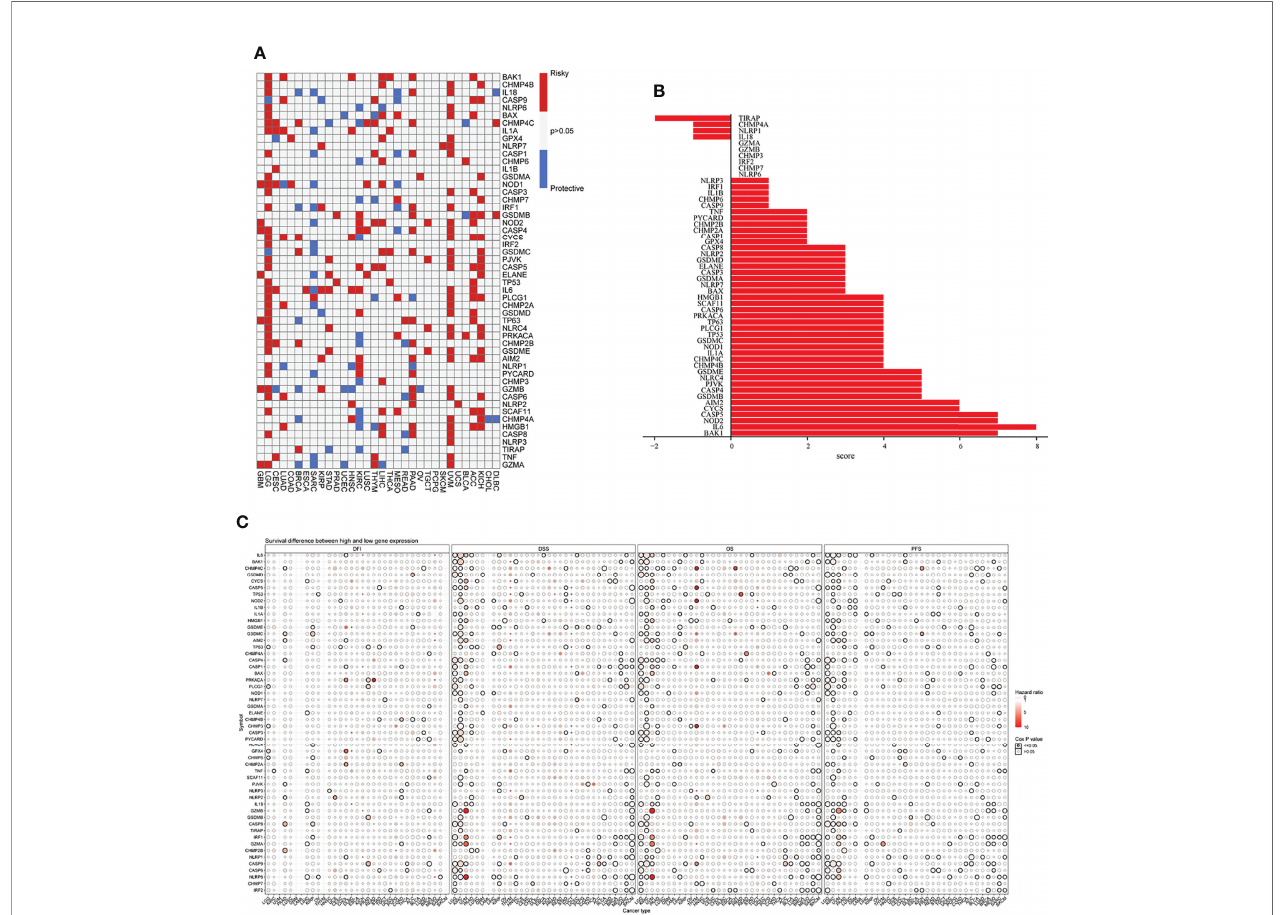
FIGURE 3 | (A) Univariate Cox regression analysis of necroptosis genes in pan-cancer. Grey denotes P >0.05, red represents P <0.05 (HR>1), while blue denotes HR<1. (B) The number of genes with signi fi cant Cox analysis in all tumors was counted. The fi nal risk score was determined by adding risk factors (+1) and subtracting protective factors ( – 1). (C) Survival difference between high and low gene expression groups. The size of the dots represents the signi fi cance of the gene ’ sin fl uence on survival for each cancer type, and the statistical signi fi cance of differences was determined by cox regression analysis. Red dots represent worse survival and blue dots represent the